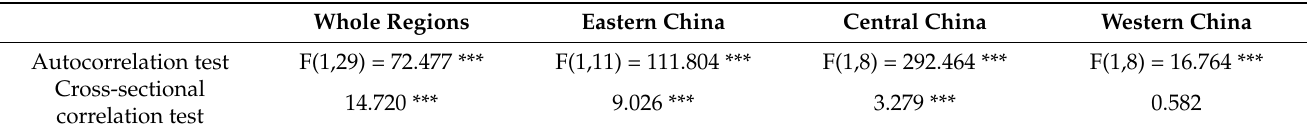
Table 9. Results of autocorrelation and cross-sectional correlation